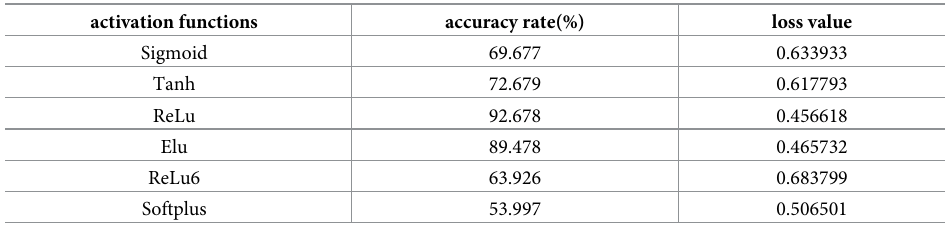
Table 6. The performance comparison of different activation